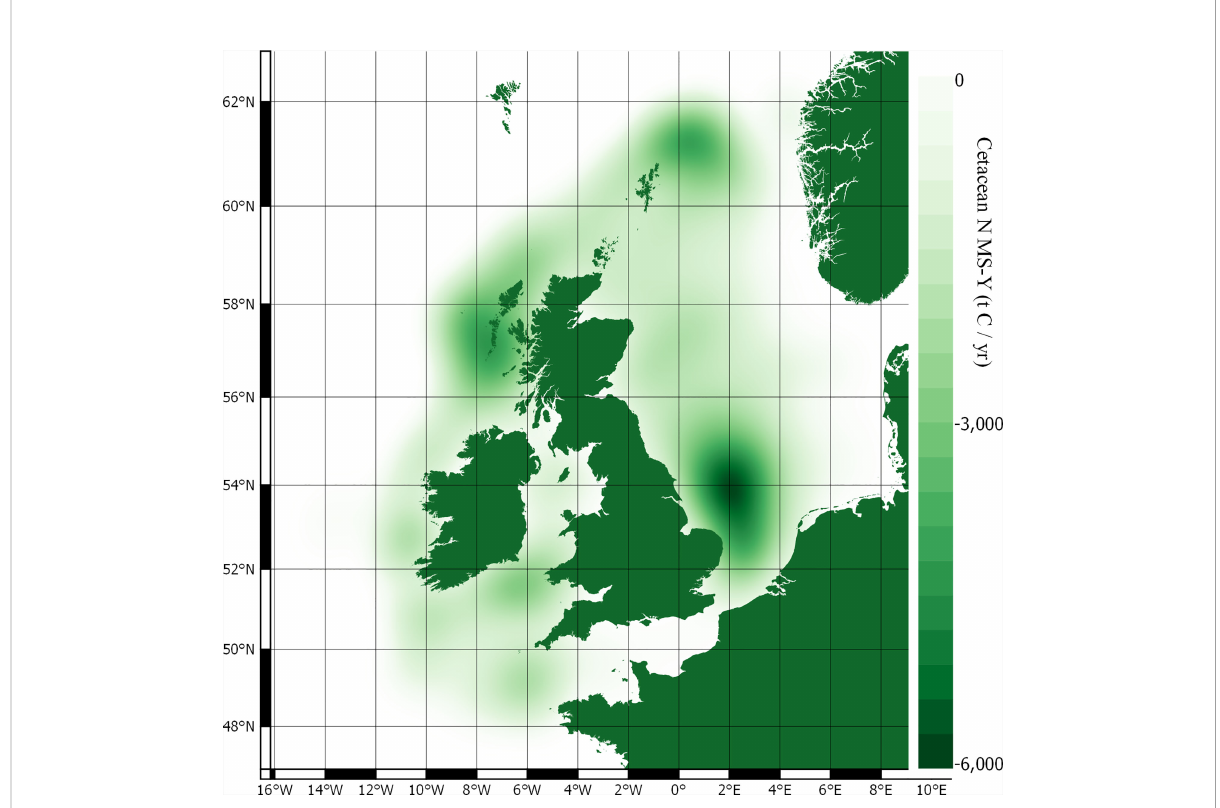
FIGURE 5 Cetacean driven N MS-Y carbon fl